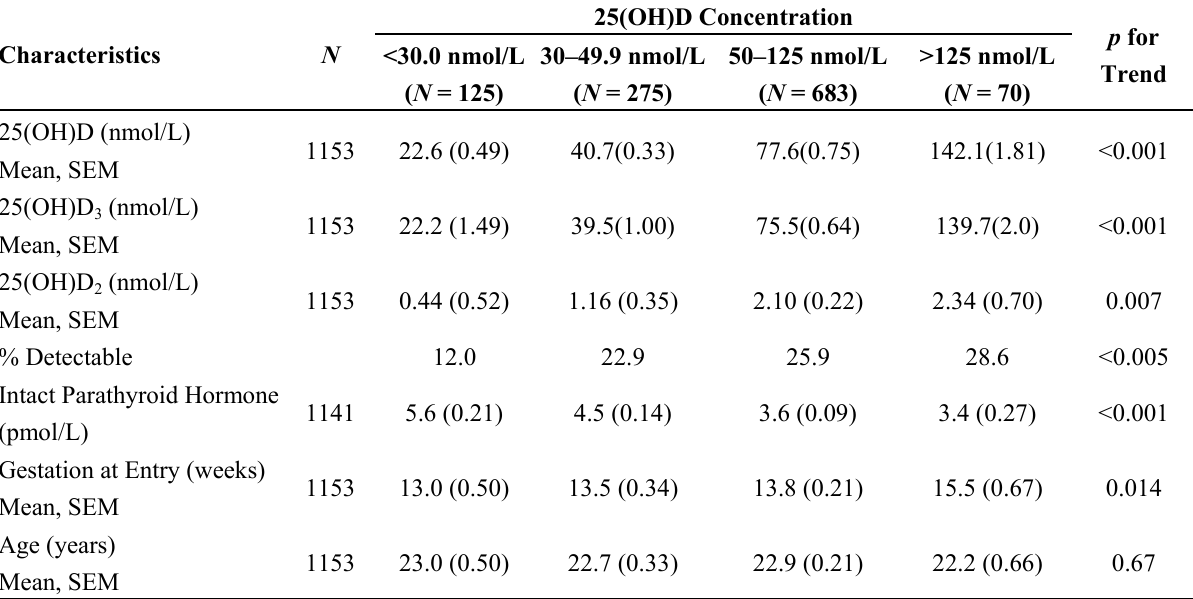
Table 1. Linear trends for maternal characteristics and intact parathyroid hormone according to categorized